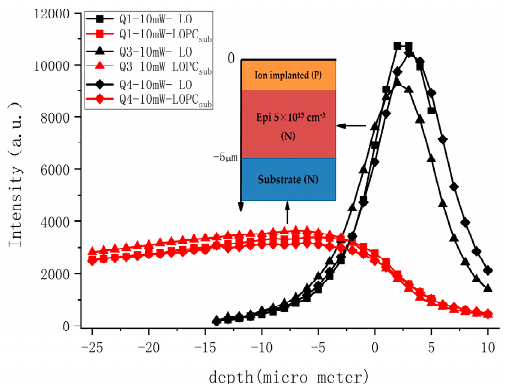
Figure 5. Relative Raman intensity of LO and LOPC sub peaks of Q1, Q3 and Q4 samples with exciting line at 532 nm with the 100 μ m pinhole at different focal plane depths.